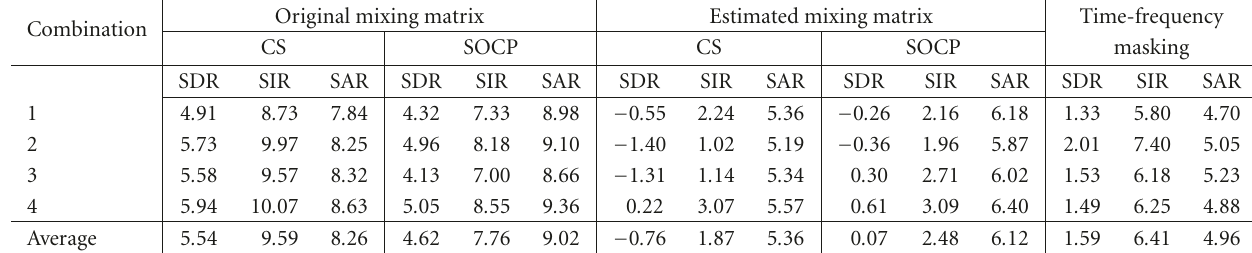
Table 3: Separation results for 4 sources (1, 3, 4, 6), 2 mixtures (1, 2).